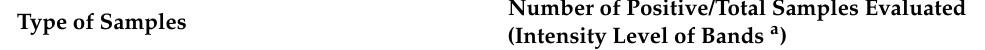
Table 1. Type of simulated whole-blood sample reactivities examined by the kit for the rapid diagnosis of human opisthorchiasis, clonorchiasis, and both diseases in human blood samples. Type of